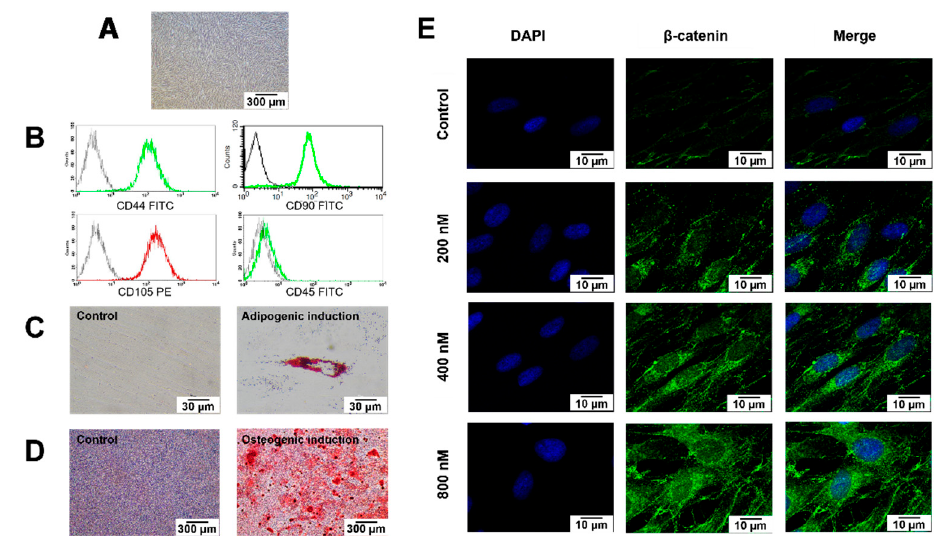
Figure 1. Characterisation of the cells isolated from dental pulp tissues. ( A ) Morphological observa- tion of human dental pulp stem cells (hDPSCs) using phase-contrast microscopy. Scale bars: 300 µm. ( B ) Evaluation of stem cell surface markers using flow cytometry. ( C ) Multi-lineage differentiation potential toward adipogenic ( D ) and osteogenic lineage. Scale bars: 30 and 300 µm. Intracellular lipid accumulation was stained by Oil Red O staining. Calcium accumulation was stained using Alizarin Red S (ARS) staining. ( E ) Representative images of immunofluorescence staining of β -catenin (stained in green) in hDPSCs; nuclei were counterstained with DAPI (shown in blue). White arrows indicate the increased nuclear translocation of β -catenin. Scale bars: 10 µm.